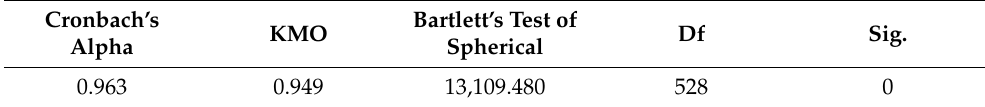
Table 2. Reliability and validity test.